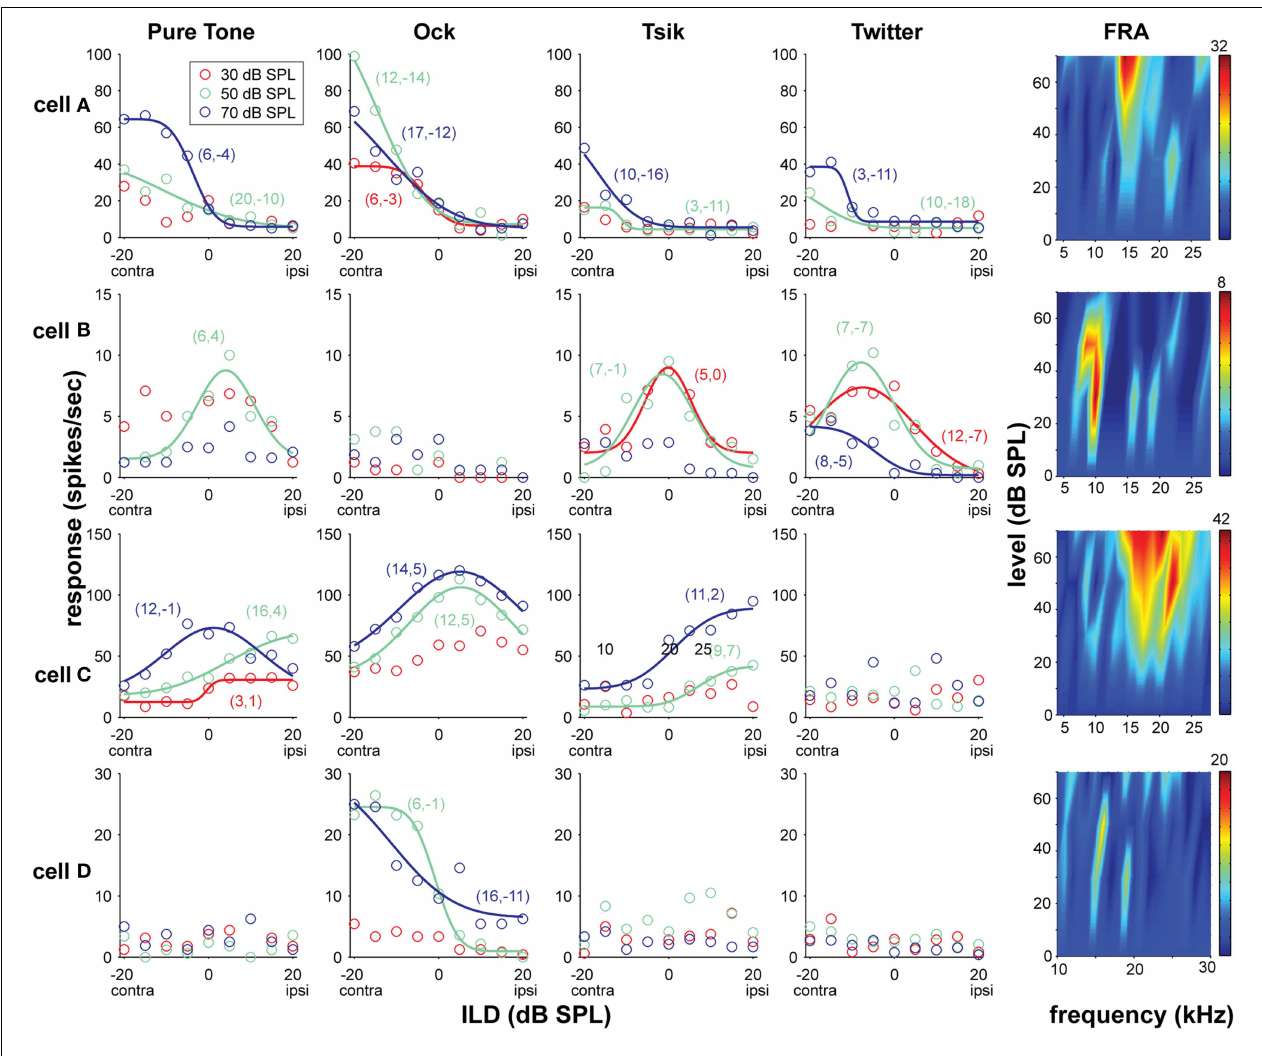
positive values refer to ones louder in the ipsilateral (ipsi) as indicated below the values on the x-axis. The values in the brackets, show in that order, are the fitted σ values and the midpoint (for monotonically selective responses) or peak (for peak selective cells) as indicated by the fitted value d 0 . The colors of these values correspond to their respective ABLs as indicated by legend. CFs for cell (A) 15kHz, (B) 10kHz, (C) 22kHz, (D) difficult to define, recorded at the area of ≈ 28kHz which was used. Spike rates in the FRAs are indicated by the color bar on the very right, the number on the top indicates the maximum value in